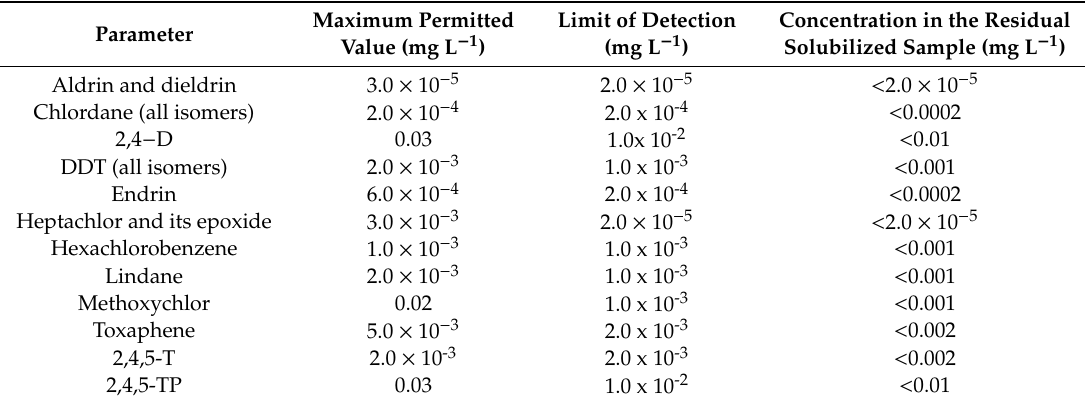
Table 5. Classification of solubility toxicity—organic parameters, measured by chromatography: maximum permitted value, limit of detection, and concentration of the solubility in the sample, according to the United States Environmental Protection Agency—USEPA